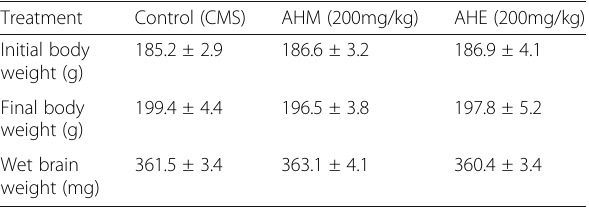
Table 3 Body weight before and after treatment and wet brain weight